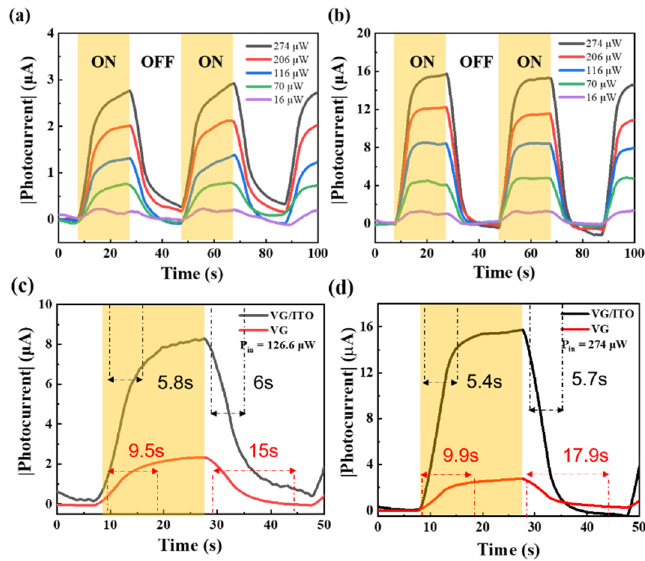
Figure 3. Transient photoresponse of VG and VG/ITO photodetector. ( a ) Time-resolved photore- sponse of the VG photodetector. |I ph | as a function of time at V bias = 0.1 V and various incident laser powers Pin (from 30.8 to 126.6 μ W). ( b ) Time-resolved photoresponse of the VG/ITO photodetector. ( c , d ) Enlarged image of one cycle of time-resolved photoresponse of the VG and VG/ITO photode- tectors, showing response and recovery times. ( c ) P in = 126.6 μ W. ( d ) P in = 274 μ W.